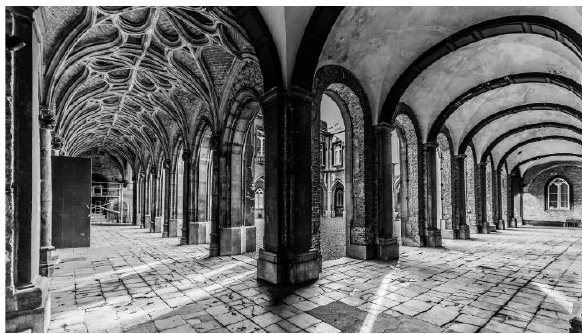
Figure 6. View from the entrance of the cloister, looking towards the southern and eastern wing. Picture taken by James McNellis, 2016. Source: